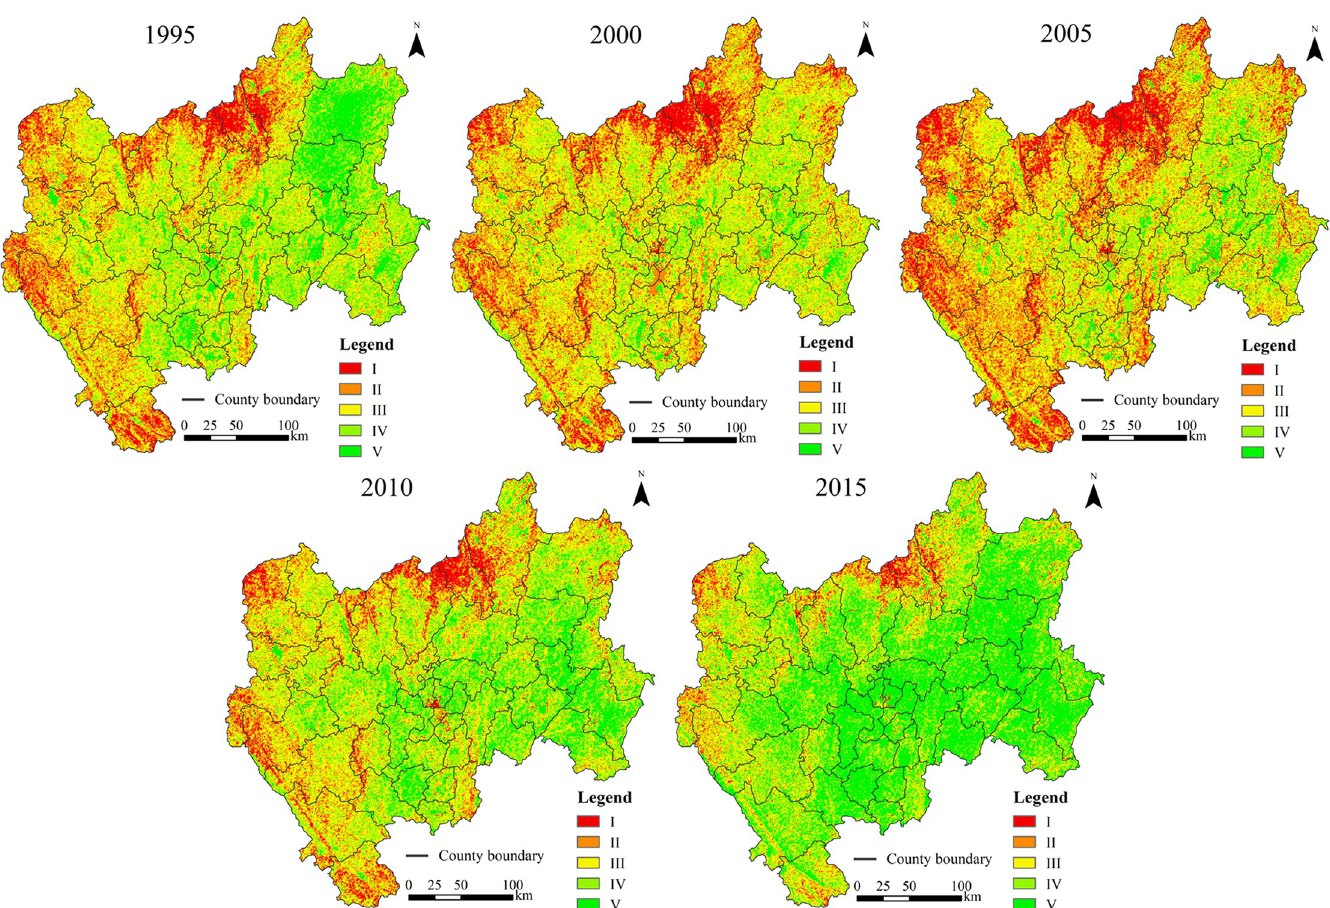
Fig 3. Distribution of ecological security levels in CYP at the pixel level.